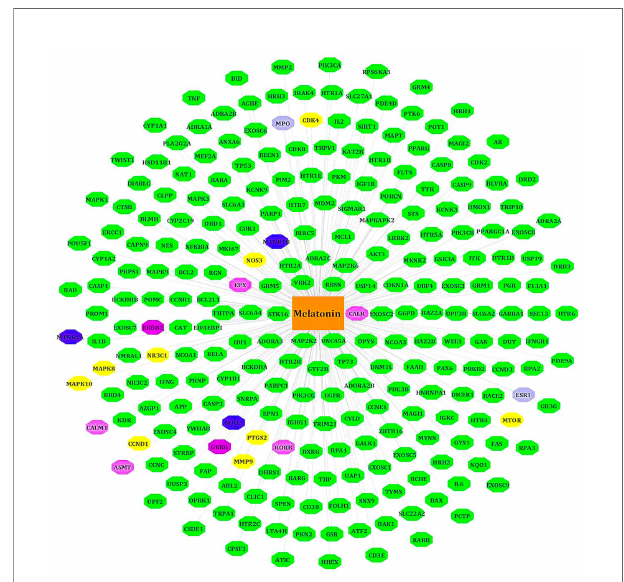
FIGURE 2 | Target genes of melatonin. All known targets of melatonin are in green nodes. The Blue nodes -intersection of Swiss target prediction/CTD/ DrugBank. Purple nodes - Swiss target prediction/Pharm Mapper. Yellow nodes - Swiss target prediction/CTD. Gray nodes - DrugBank/Swiss target prediction or CTD. Pink nodes –